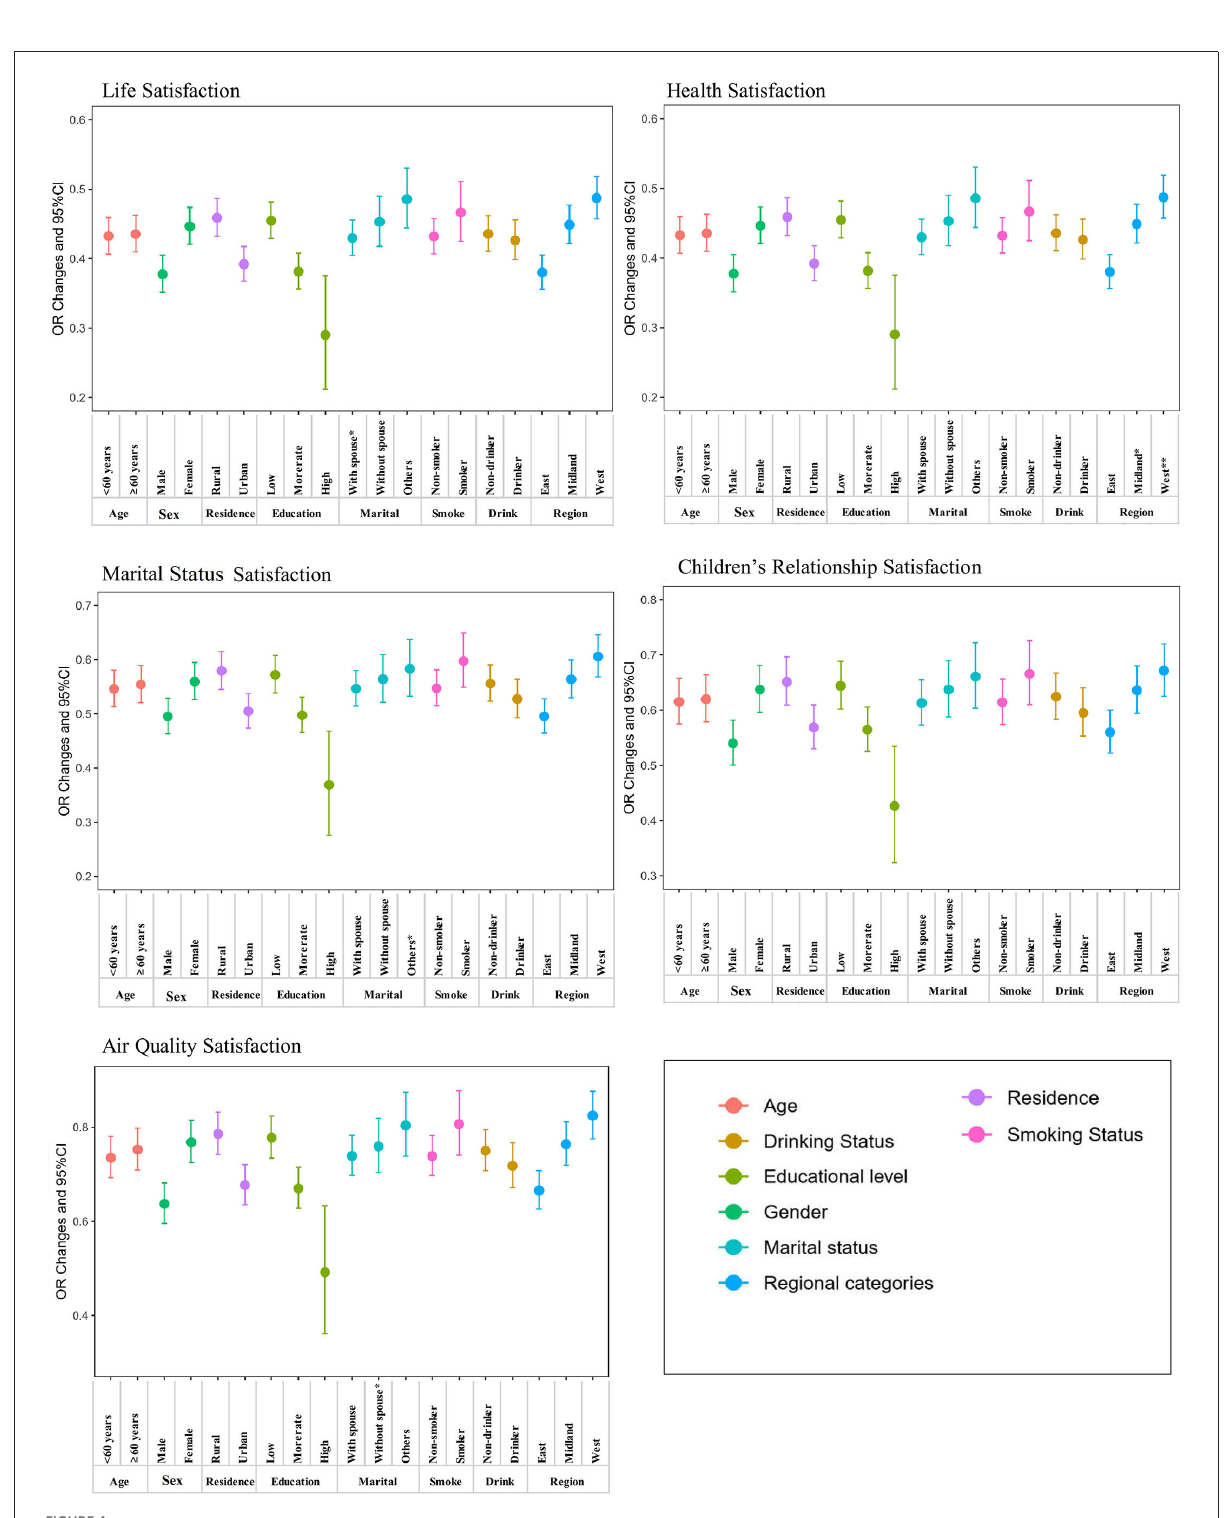
FIGURE4 Stratified analysis of the association of depressive symptoms with every 1-point increase in